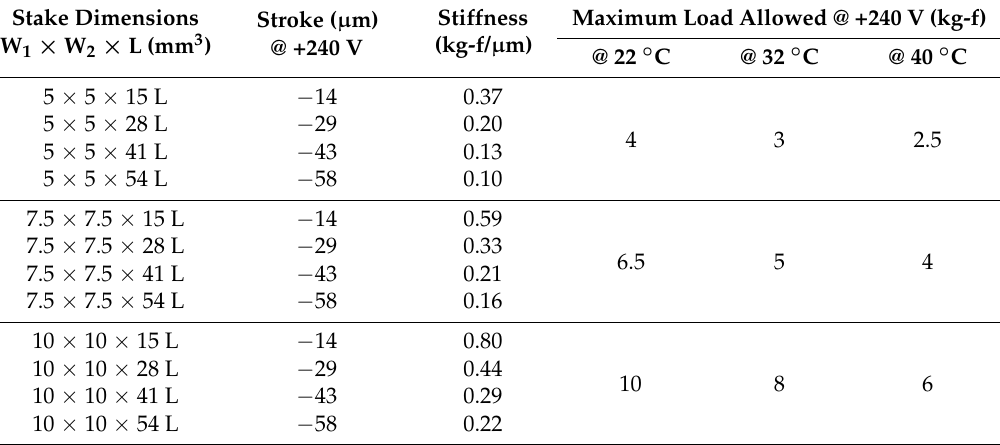
Table 1. Summary of dimensional and performance specifications of ‘Hi-Fi stake’ actuators. Stake Dimensions